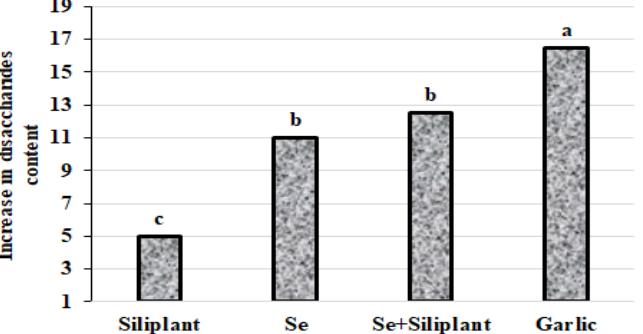
Figure 5. Changes in disaccharide content in Raphanus sativus var. lobo treated with Siliplant, Se and garlic extract.